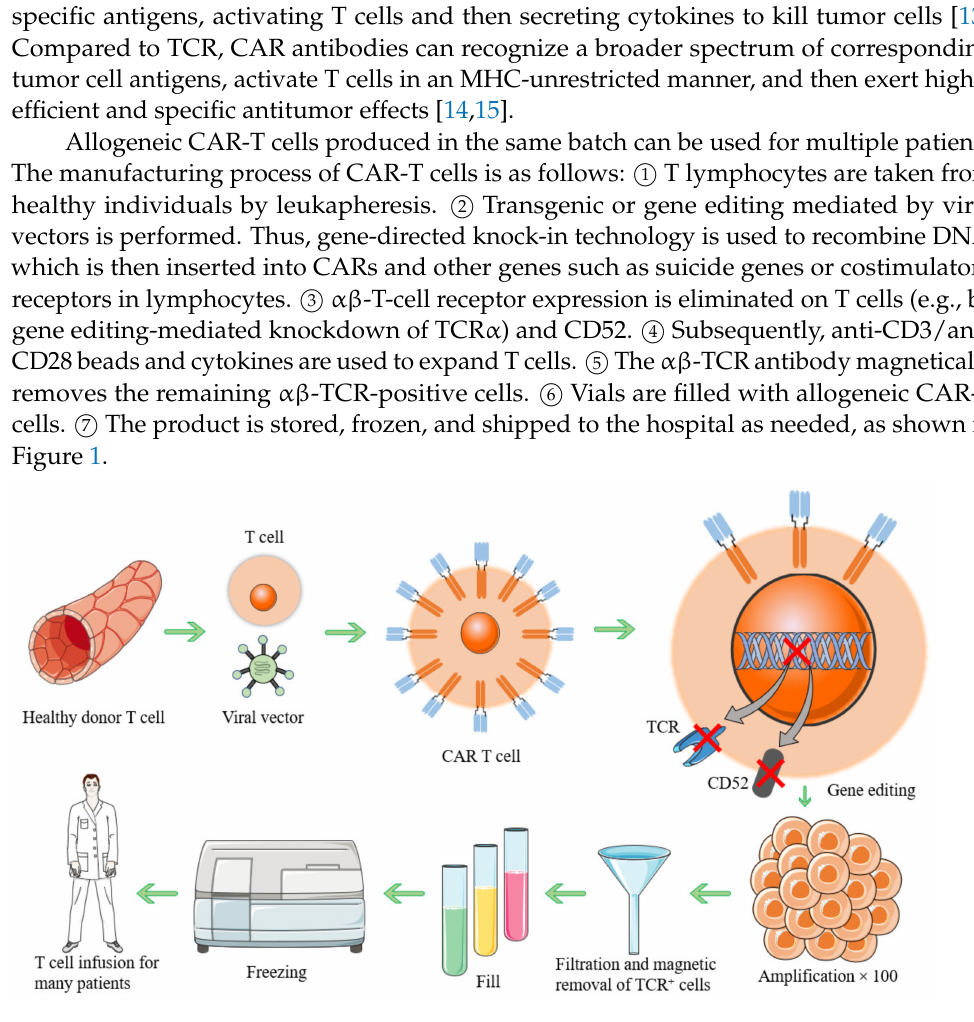
Figure 1. Flowchart of allogeneic CAR-T-cell